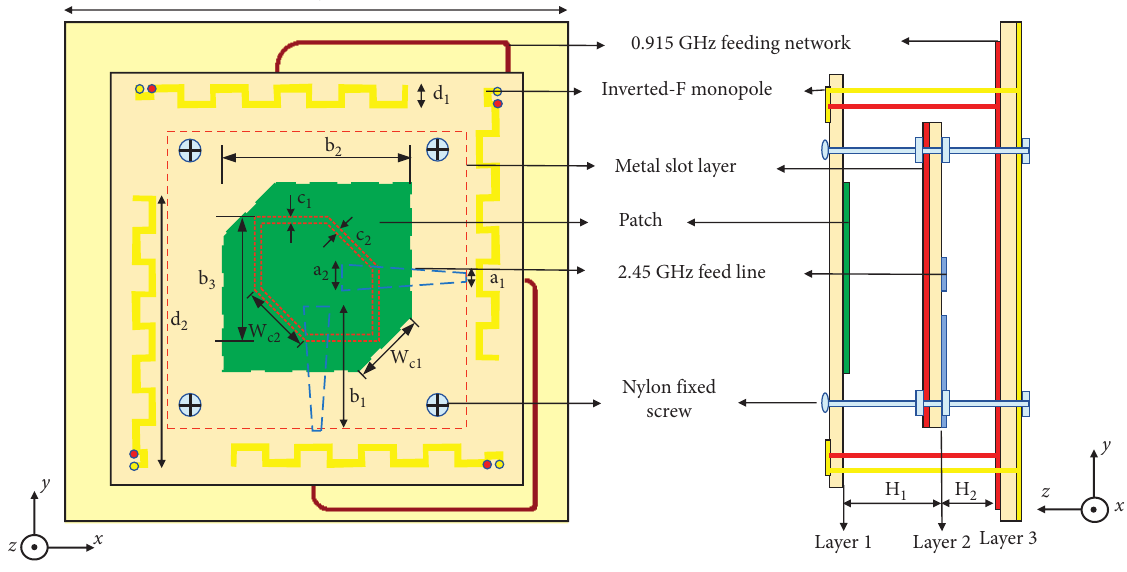
Figure 1: Antenna structure’s top view and side